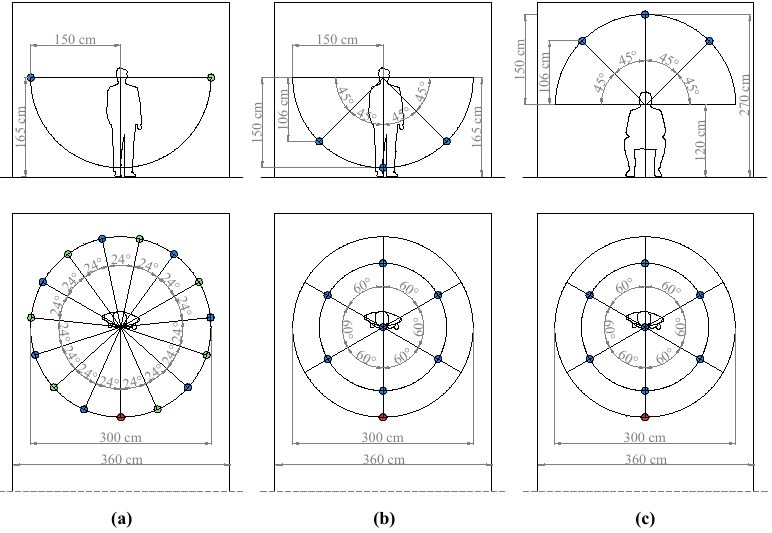
Figure 4. Microphones placement during measurement for sound source characterization. (( a ) source medium level, ( b ) source bottom level, ( c ) seated source top